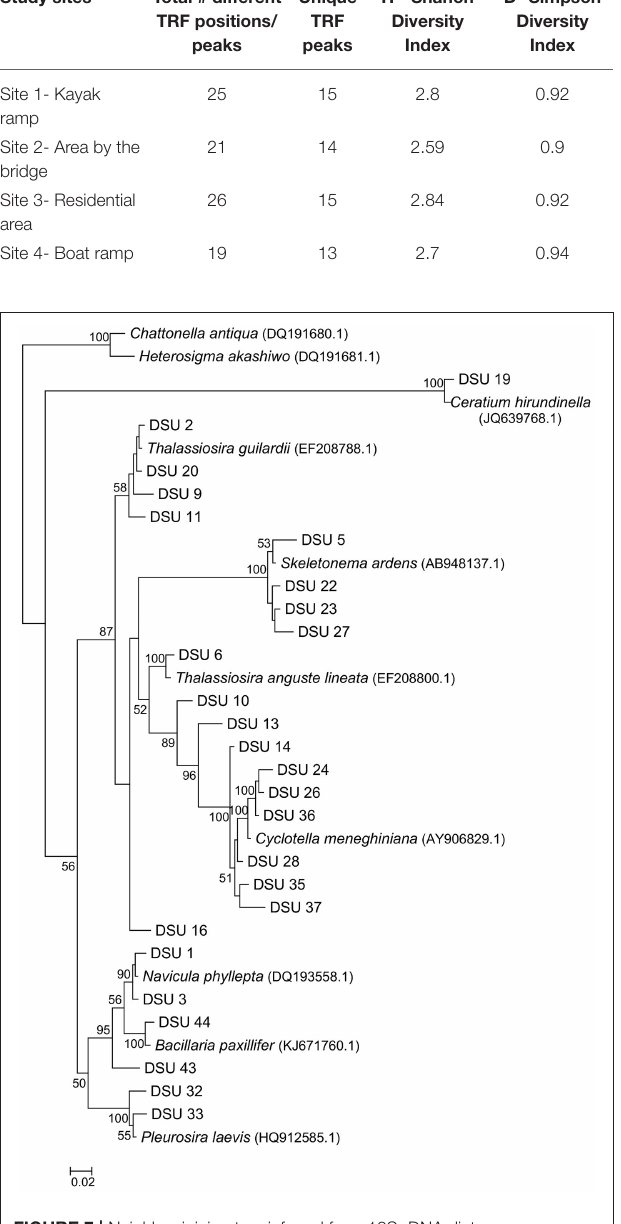
FIGURE 7 | Neighbor joining tree inferred from 18S rDNA diatom sequences. Boot strap values are only shown for nodes on the main trunk of the tree; the bar represents 0.02 nucleotide substitution per